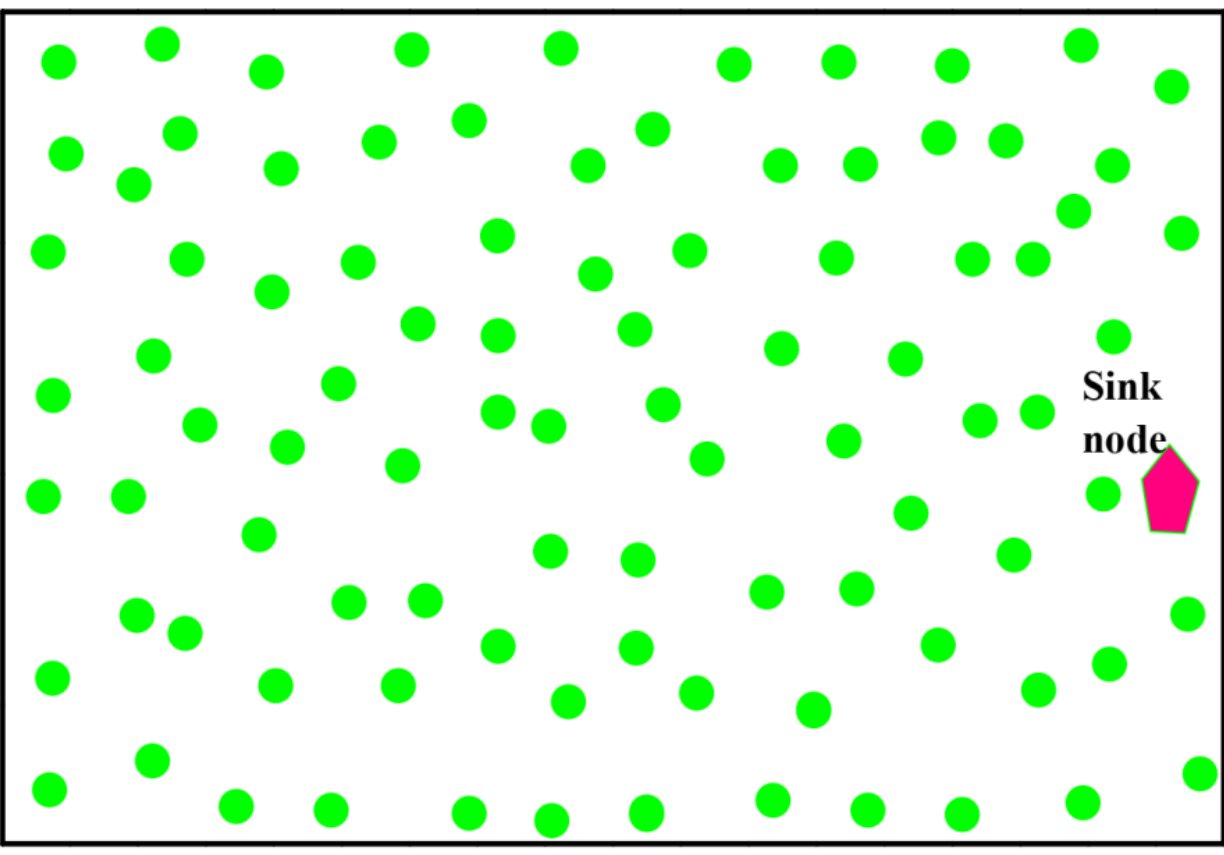
Figure 1. WMSN model.